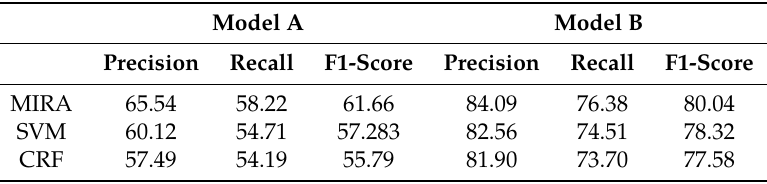
Table 17. Experimental results of each classifier for Models A and B.